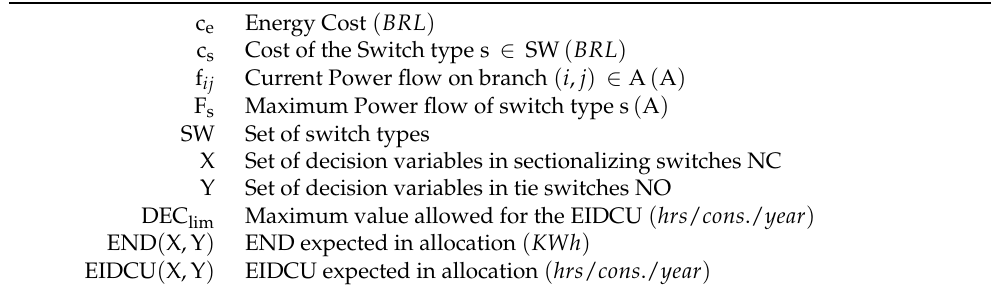
Table 1. Mathematical model